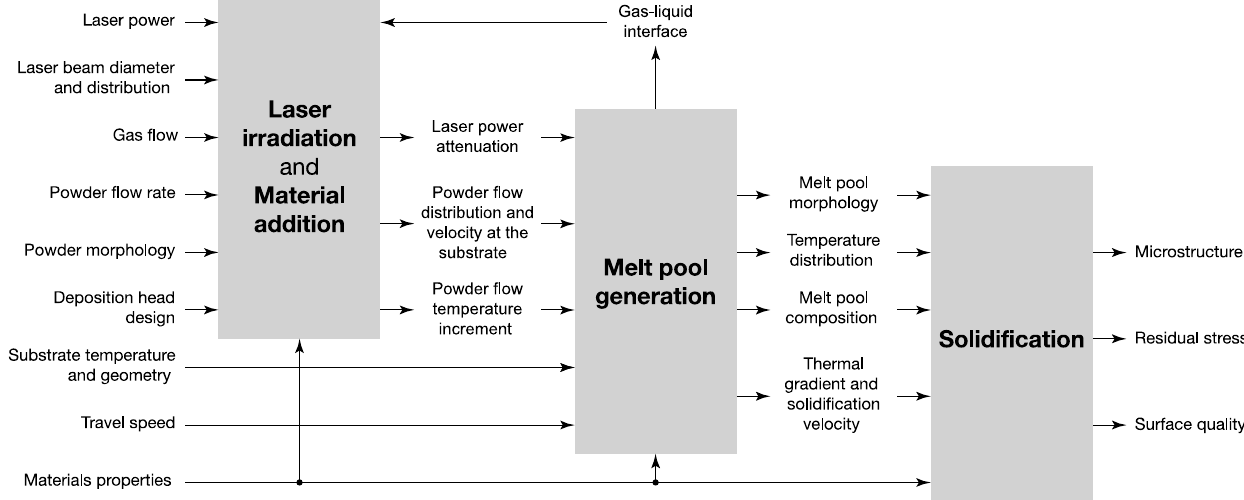
Figure 2. Main mechanisms and process parameters describing the physics of the LP-DED process (adapted from [23]).